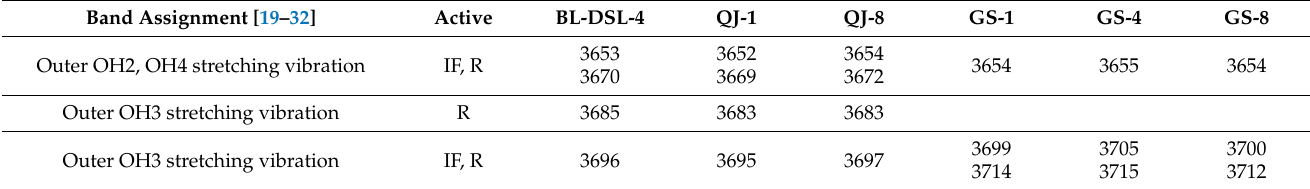
Table 3. The bands in the range of 4000–8000 cm − 1 for related samples and their assignments (cm − 1 ).